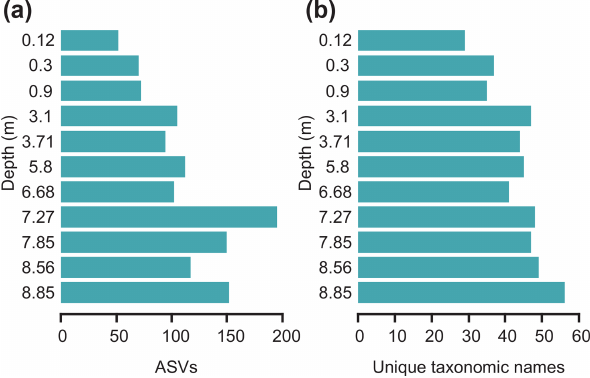
Figure 4. Bar plots showing the rarefied (a) number of amplicon se- quence variants (ASVs) per sample and (b) grouped ASVs assigned to the same taxonomic name for each sample with depth (m) of the sediment core